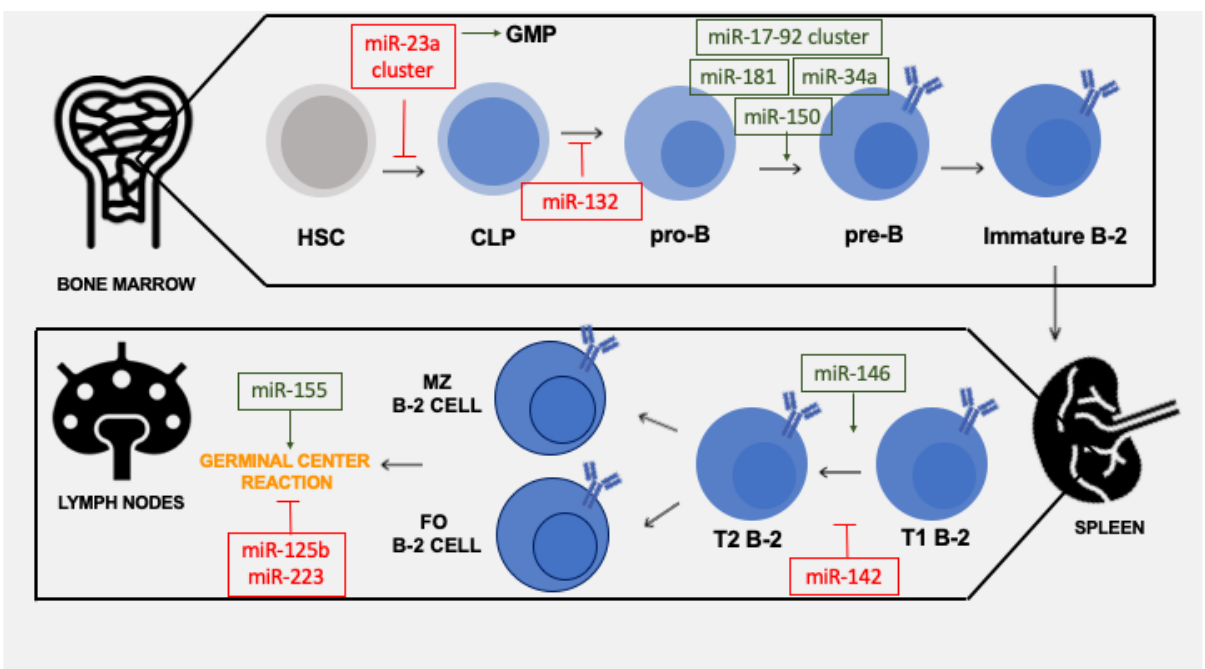
Figure 1. MicroRNAs participate in the B-cell differentiation and maturation by negative control (red) or induction (green) of genes related to B-cell counterparts. In bone marrow stages, microRNAs miR-17-92 cluster, miR-181, miR-34a, and miR-150 act along cell differentiation. Contrariwise, miR-23a and miR-132 blocks B cell differentiation. In the periphery, miR-146 and miR-142 have roles in transitional B-cells in the spleen and miR-155, miR-125 and miR-223 regulate germinal center reaction in lymph nodes.